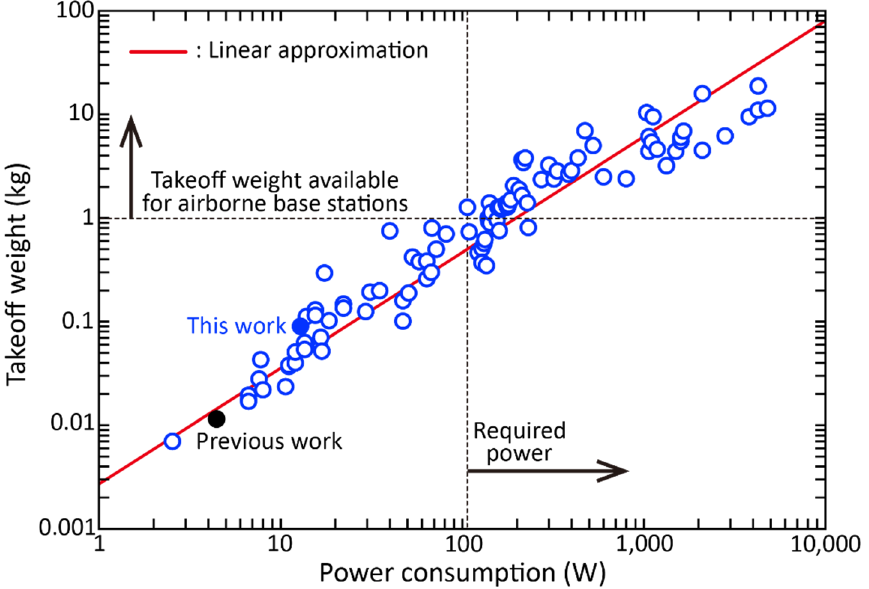
Figure 11. Takeoff weight versus power consumption of commercially available drones. Dashed lines show thresholds of takeoff weight and required power available for airborne base stations. The effect of weather on the use of drones as airborne base stations is also